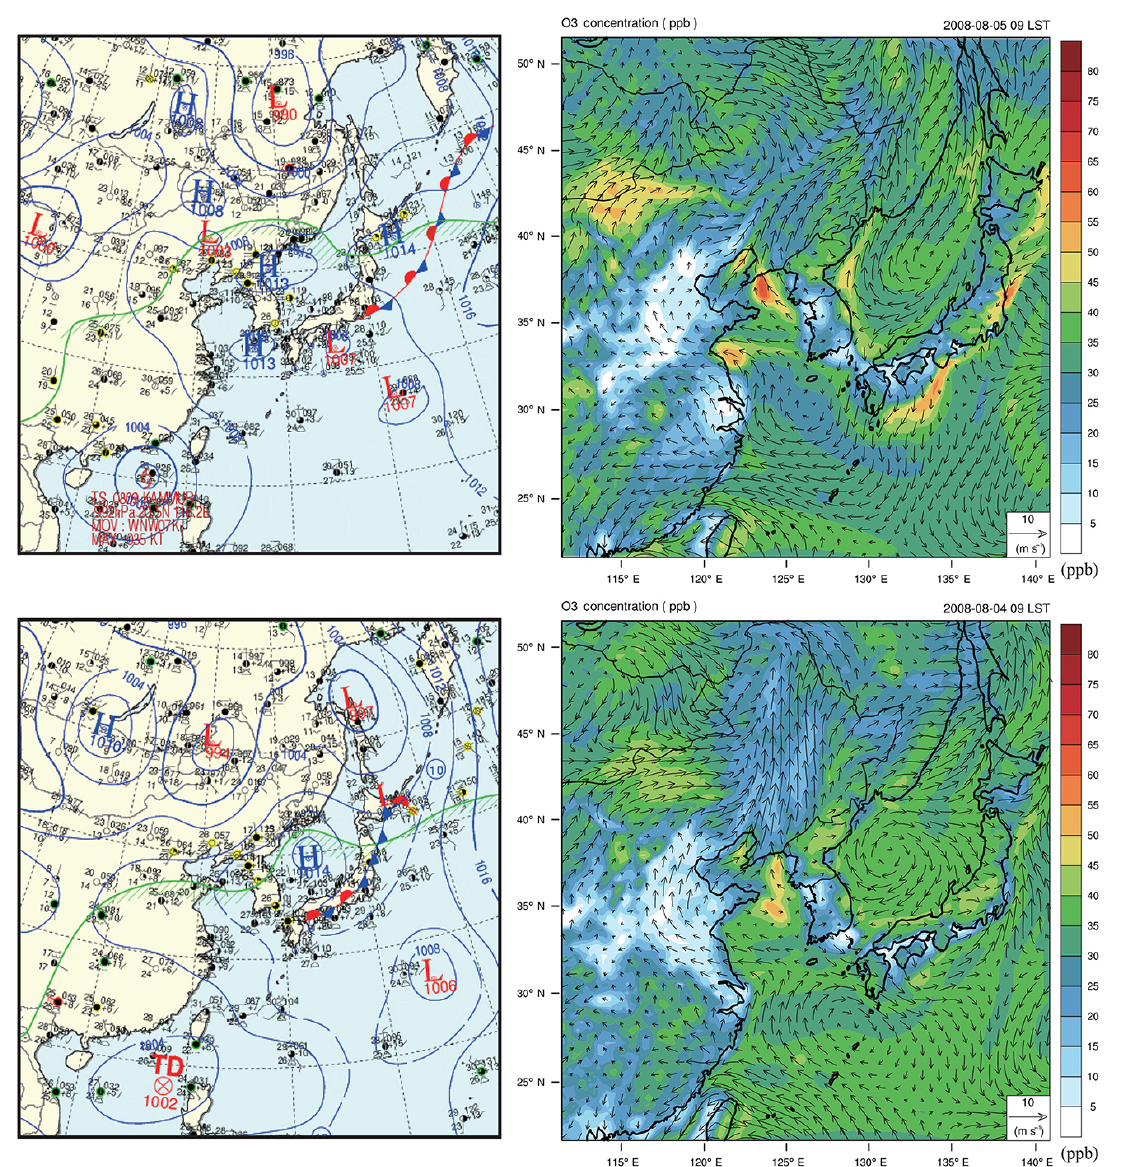
Figure 3. Synoptic weather charts (left) and simulated results (right) on 4 August (upper) and 5 August (lower). Filled contours and vectors represent ozone concentration and winds,